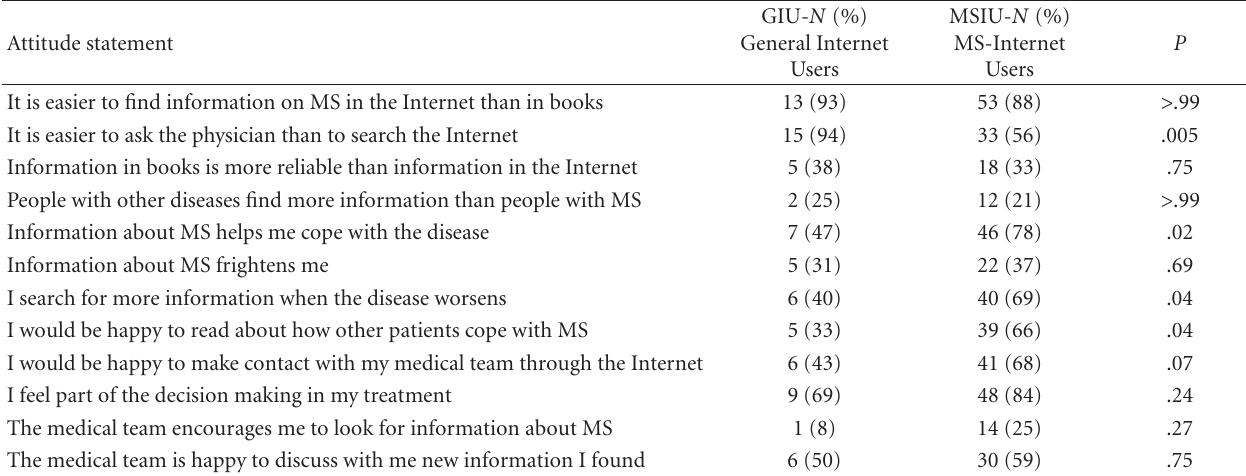
Table 2: Participants’ attitudes about information and the internet: number and percentage of patients that agree with attitude statements.